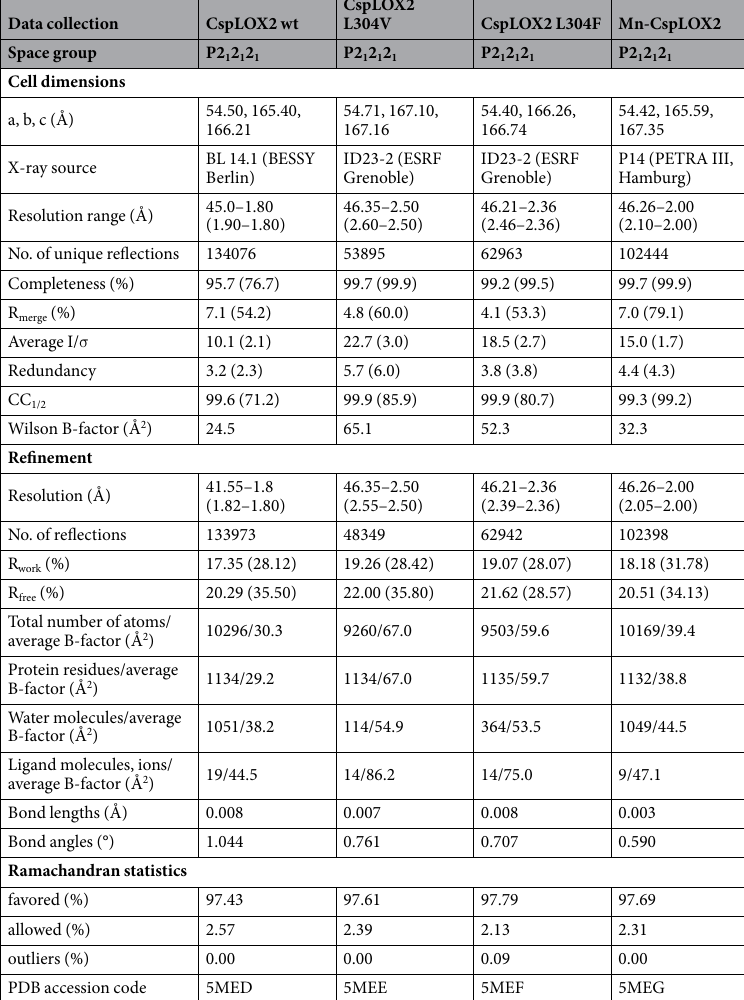
Table 2. Data collection and refinement